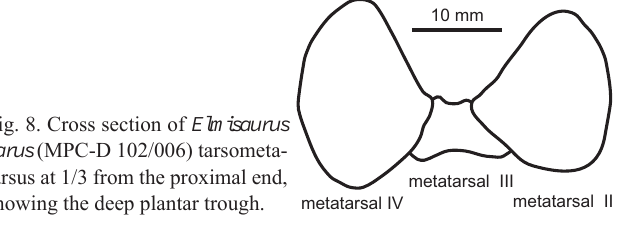
Fig. 8. Cross section of Elmisaurus rarus (MPC-D 102/006) tarsometa- tarsus at 1/3 from the proximal end, showing the deep plantar